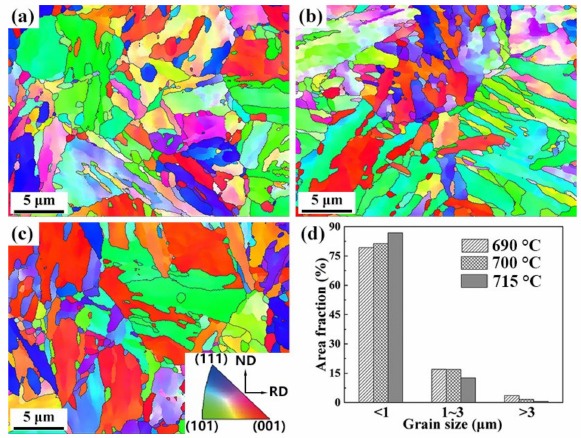
Figure 5. The grain orientation maps of the 0.5Cr0.4W steels tempered at ( a ) 690 ◦ C, ( b ) 700 ◦ C, ( c ) 715 ◦ C, and ( d ) the histograms showing their grain size distributions. The local average misorientations (LAM) for the three tempered samples are shown